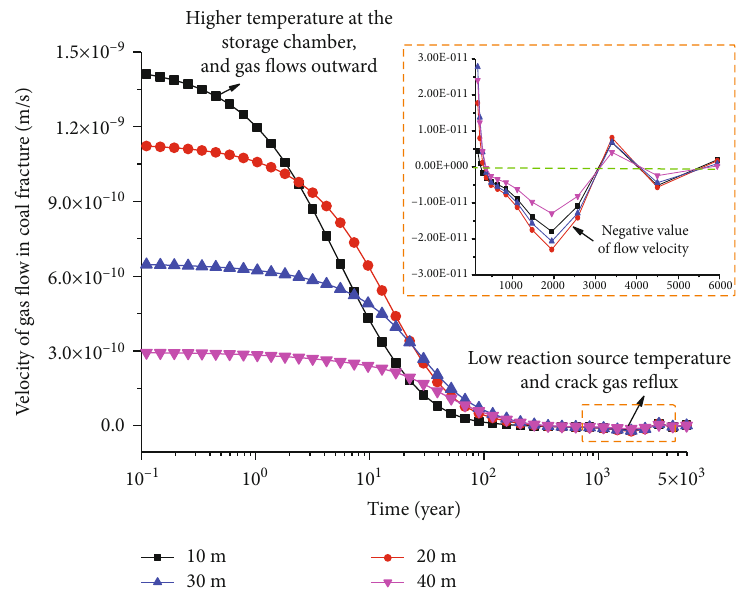
Figure 7: Velocity of gas fl ow in the fracture network.